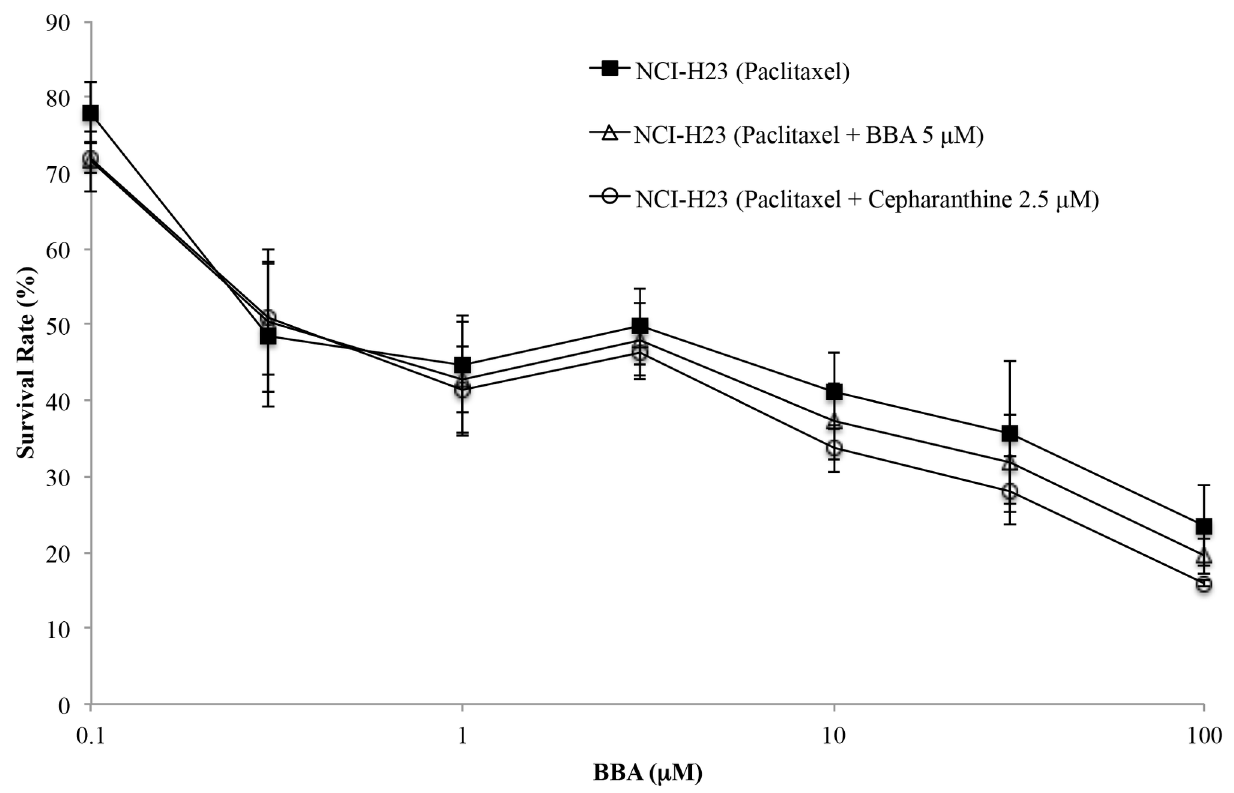
Figure 3. BBA does not affect the sensitivity to paclitaxel in NCI-H23 cells. doi: